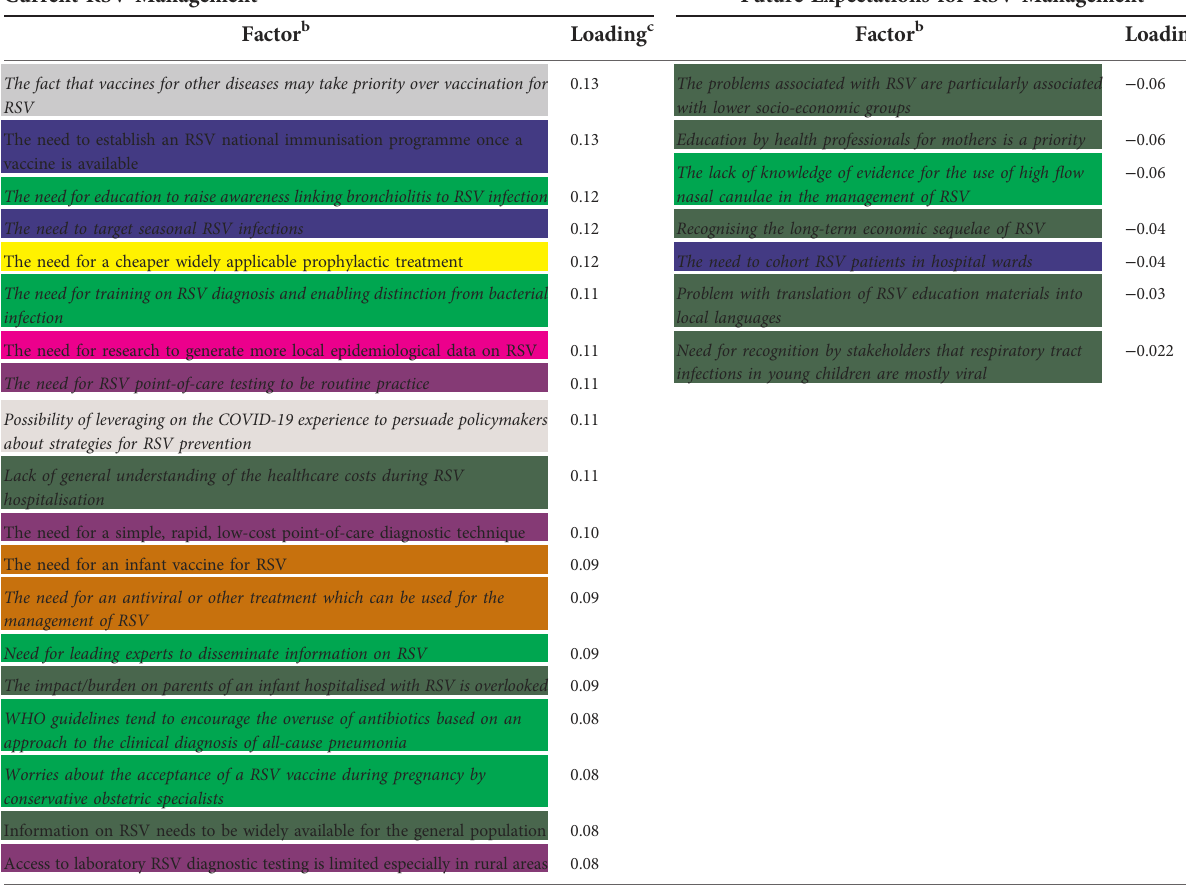
TABLE 3 Key factors distinguishing between current and future management of RSV in LMICs a .